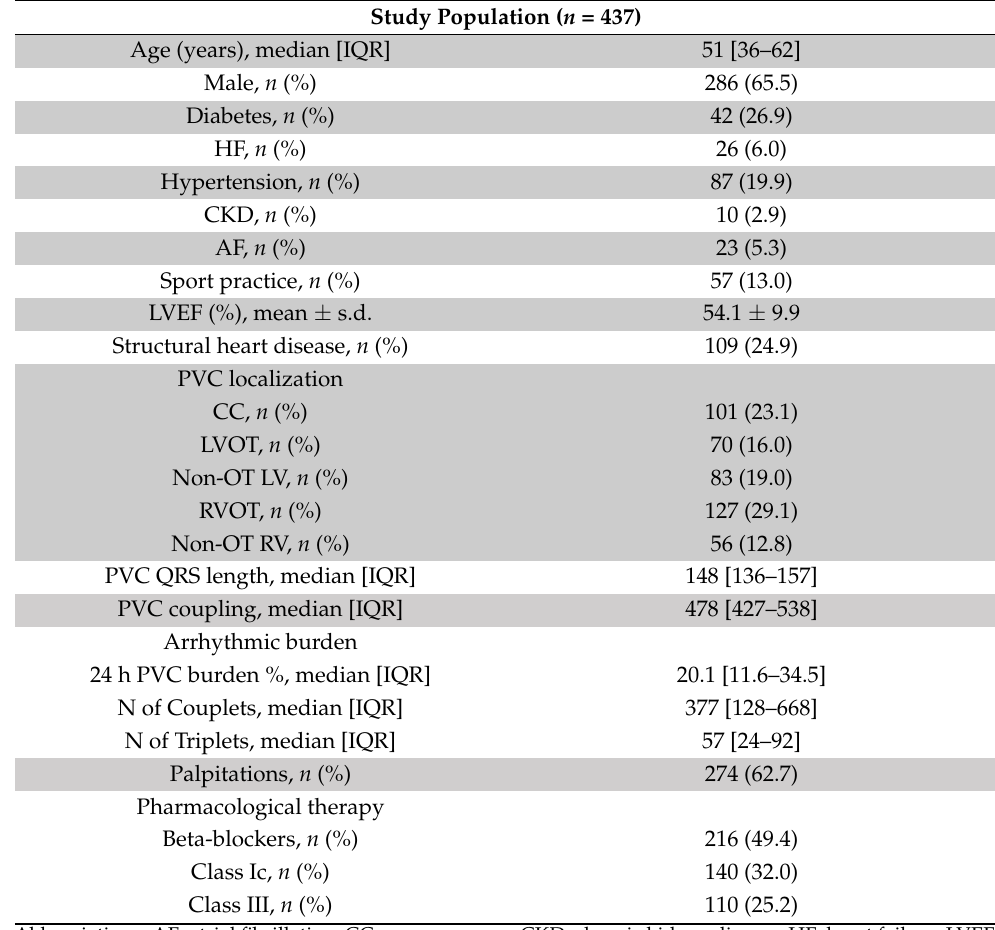
Table 1. Baseline Characteristics of the Study